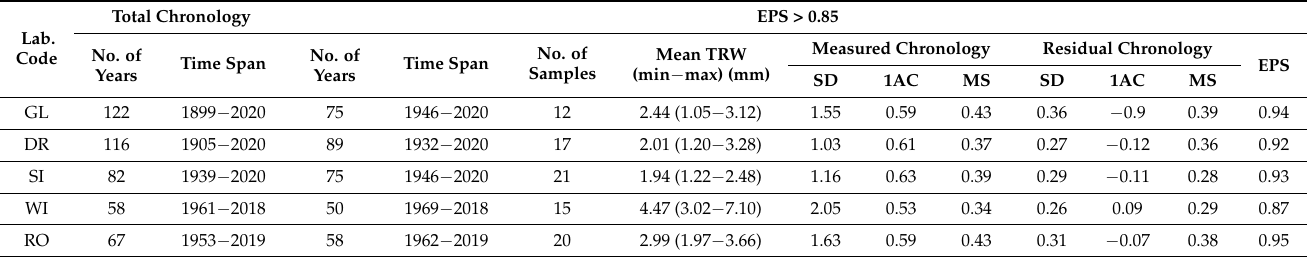
Table 3. Basic statistics of standard and index (residual) Sawara cypress local chronologies. Lab. Code